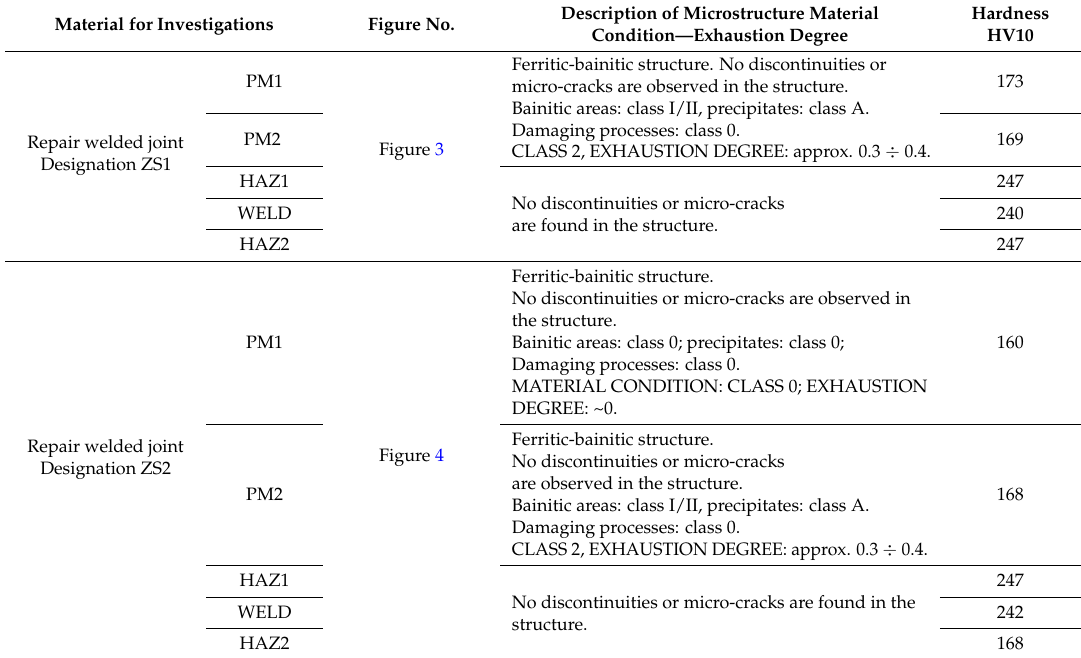
Table 4. Phase composition of carbides in repair welded joints. Material Condition Phase Composition of